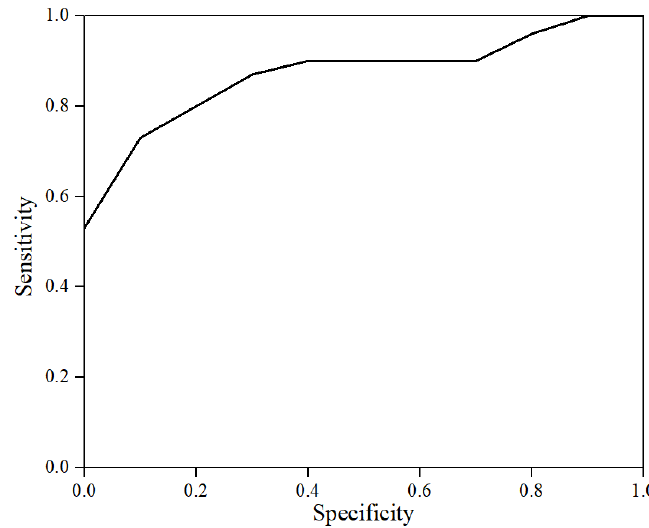
Figure 2. Receiver operating characteristic curve.